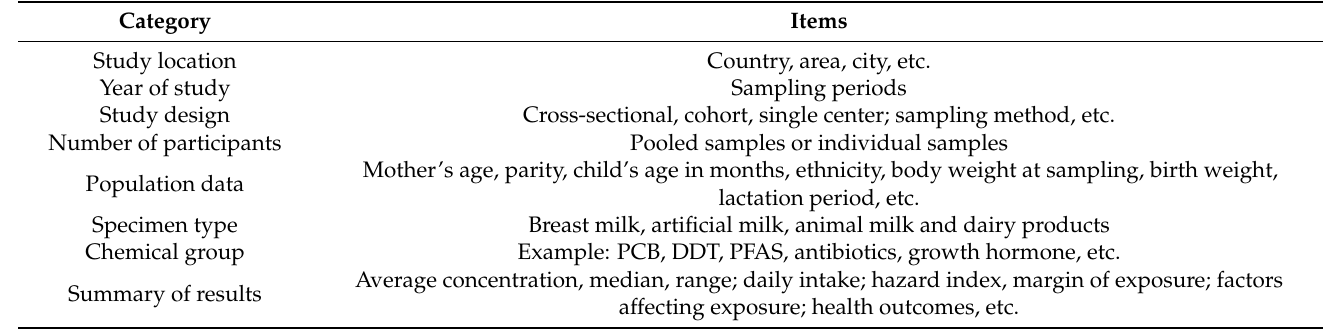
Table 2. Summary of data items to be